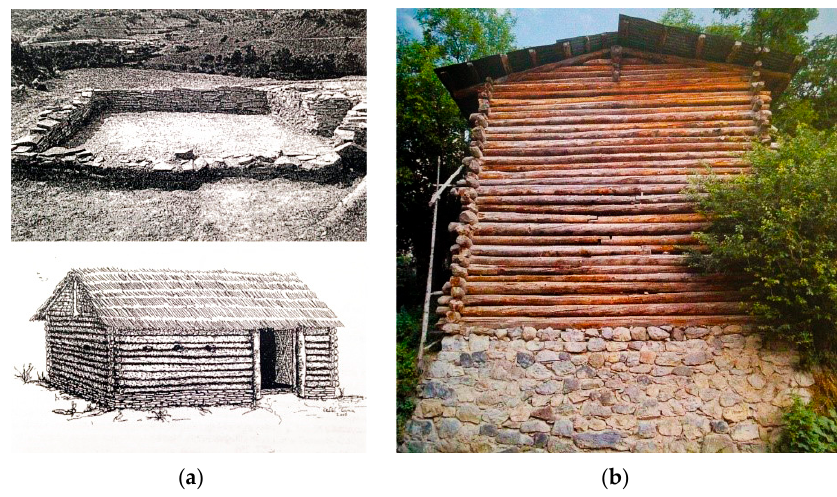
Figure 1. Sustainable building culture in Eastern Black Sea Region as: ( a ) Shows the foundations and restitution of the structure revealed in Boyabat/Kovuklukaya (Tuna 2008); ( b ) Shows the vernacular house at Cevizli Village/Artvin at present (Gür and Batur 2005).